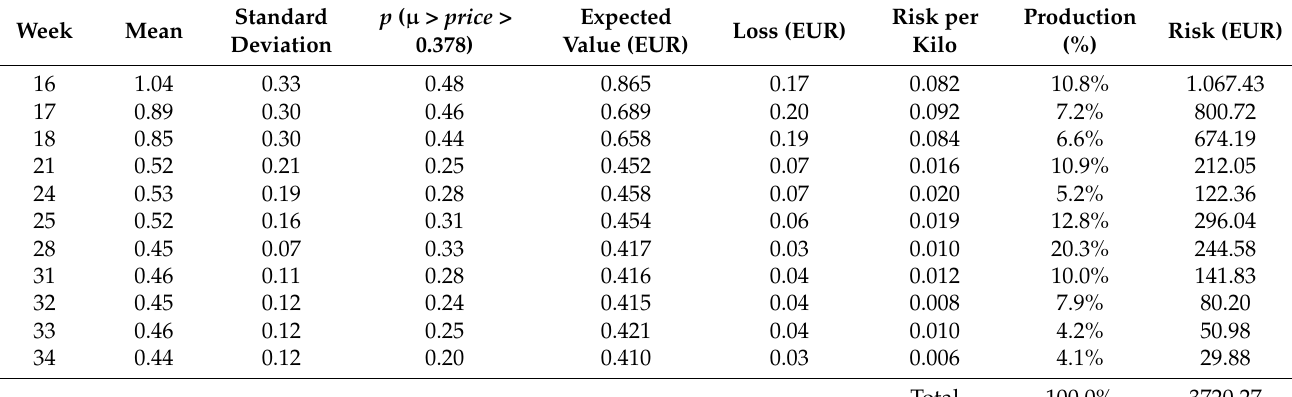
Table 2. Obtaining weekly risk due to a temporary fall in prices based on the mean and standard